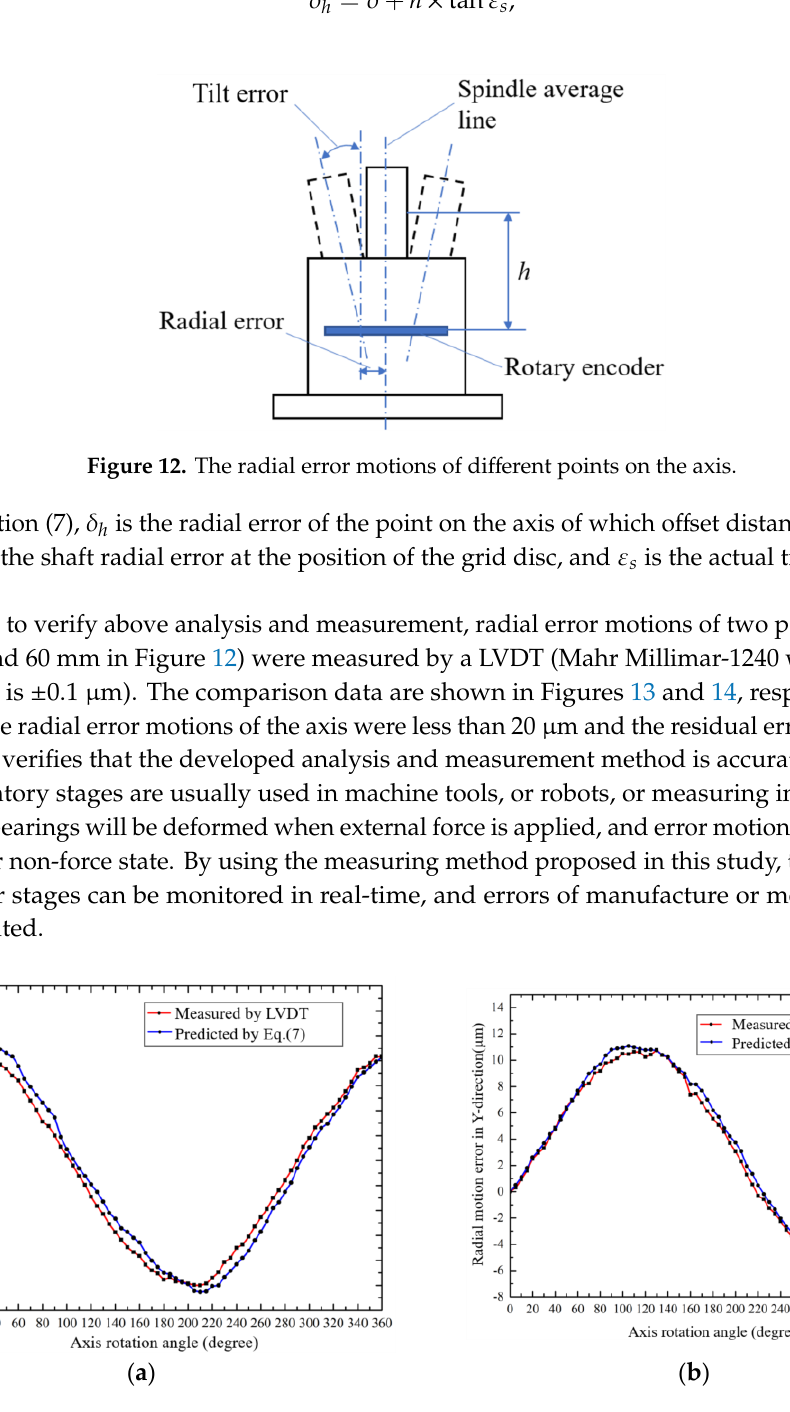
Figure 13. The radial error motion of the axis ( h = 5 mm): ( a ) X-direction; ( b ) Y-direction.